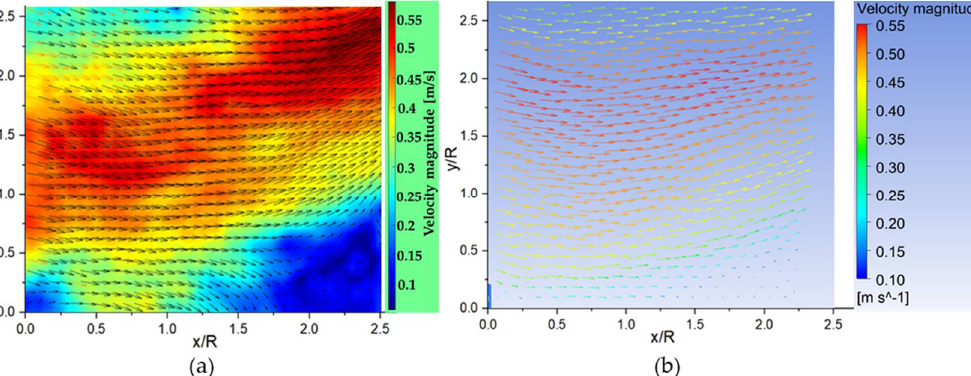
Figure 10. Velocity magnitude color maps: ( a ) PIV and ( b ) CFD simulation.